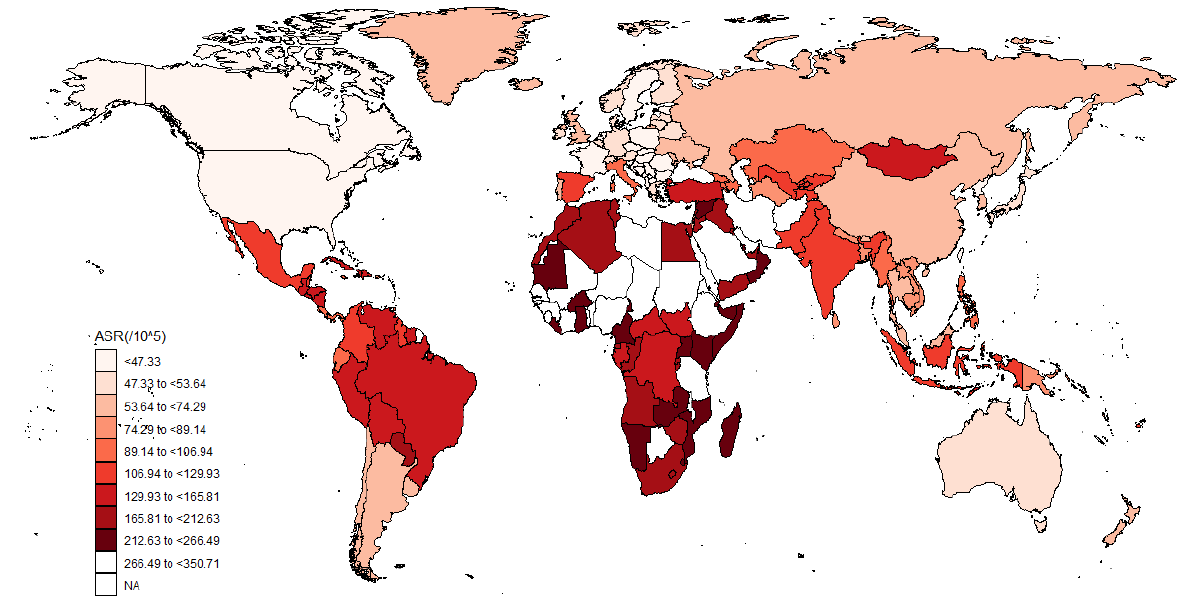
Figure 2. The global disease burden of glaucoma for both sexes in 204 countries and territories in 2019. ASR: age-standardized prevalence rate. J. Clin. Med. 2023 , 12 , x FOR PEER REVIEW